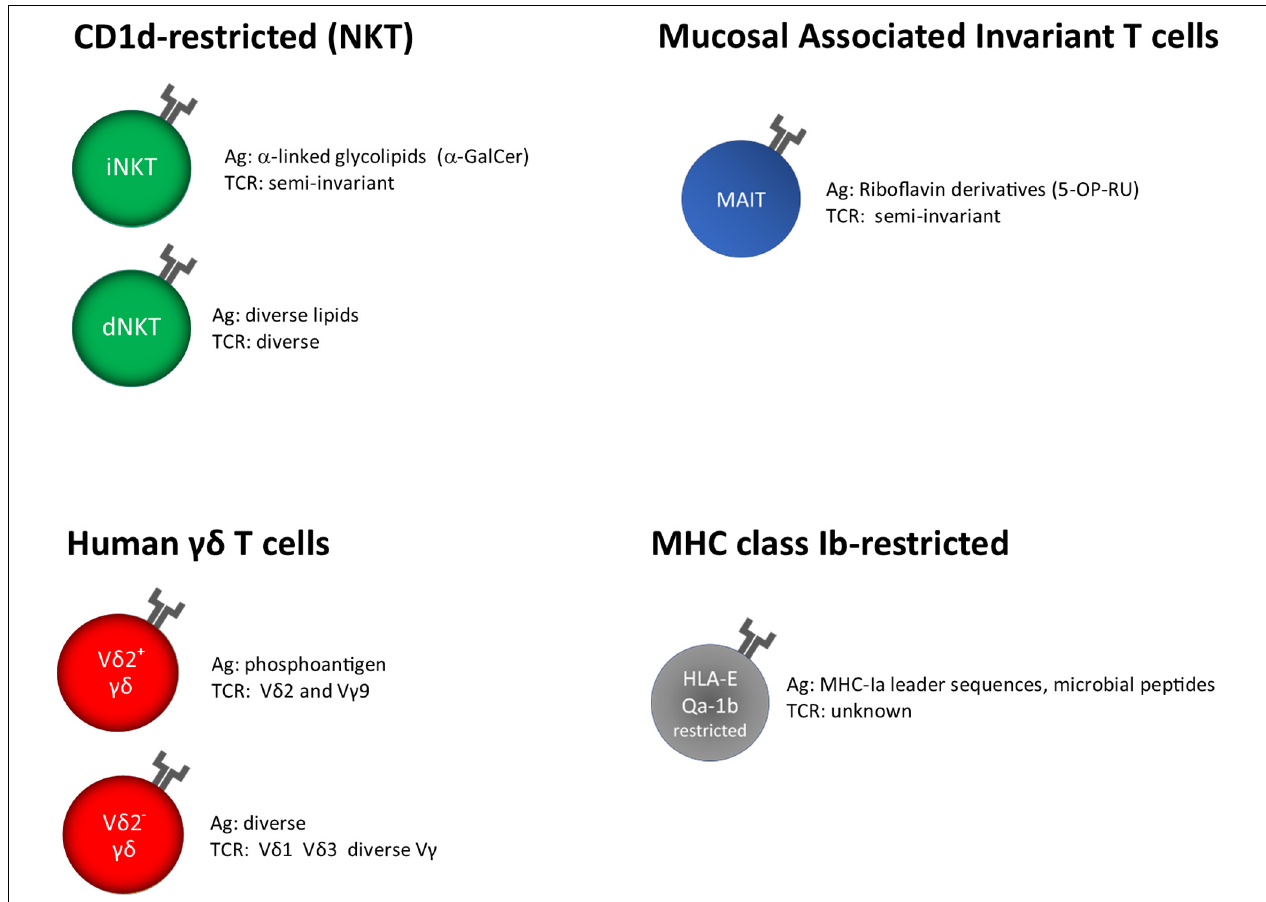
FIGURE 1 | Unconventional T cells, grouped on the base of their restriction elements. α -GalCer, α -galactosyl ceramide; 5-OP-RU, 5-(2-oxopropylideneamino)-6-D- ribitylaminouracil; unknown, insufficient or very limited